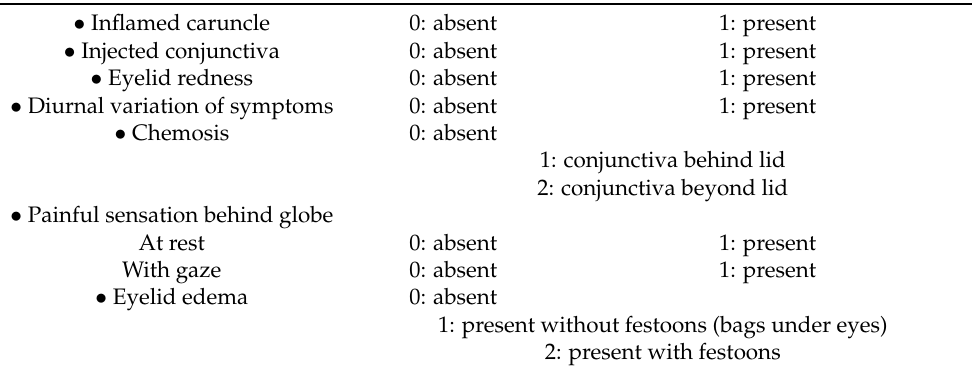
Table 3. VISA (Vision, Inflammation, Strabismus, and Appearance)